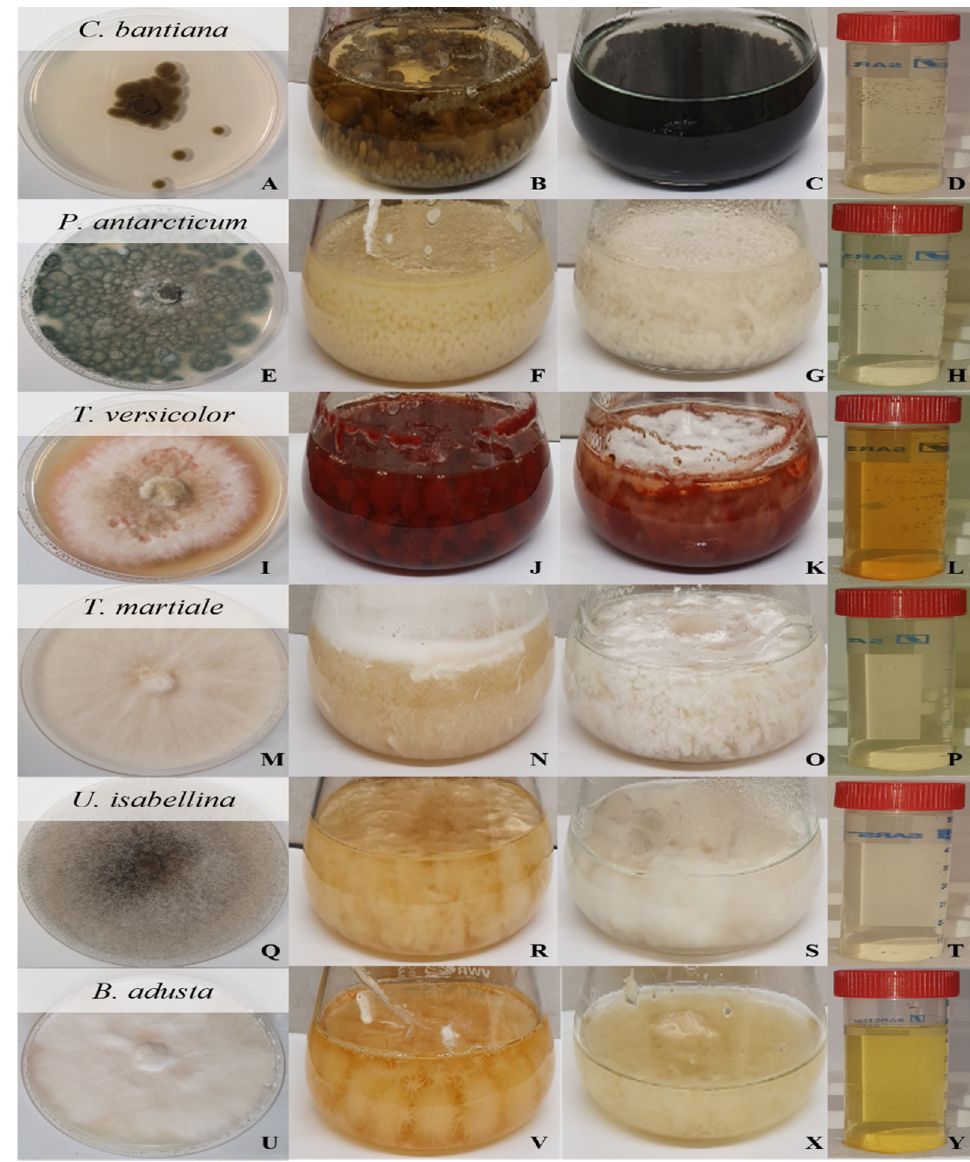
Figure 1. Fungus growth in MYPG agar plates (first column), MYGP medium (second column), stress medium (third column) and the fungal cell-free extract (fourth column): Cladophialophora bantiana ( A – D ), Penicillium antarcticum ( E – H ), Trametes versicolor ( I – L ), Trichoderma martiale ( M – P ), Umbelopsis isabellina ( Q – T ) and Bjerkandera adusta ( U – Y ).